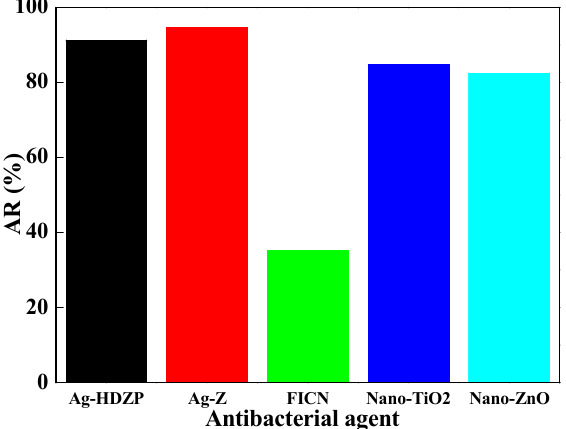
Figure 2. Antibacterial ratio of di ff erent antibacterial agents loaded with melamine resin coatings.